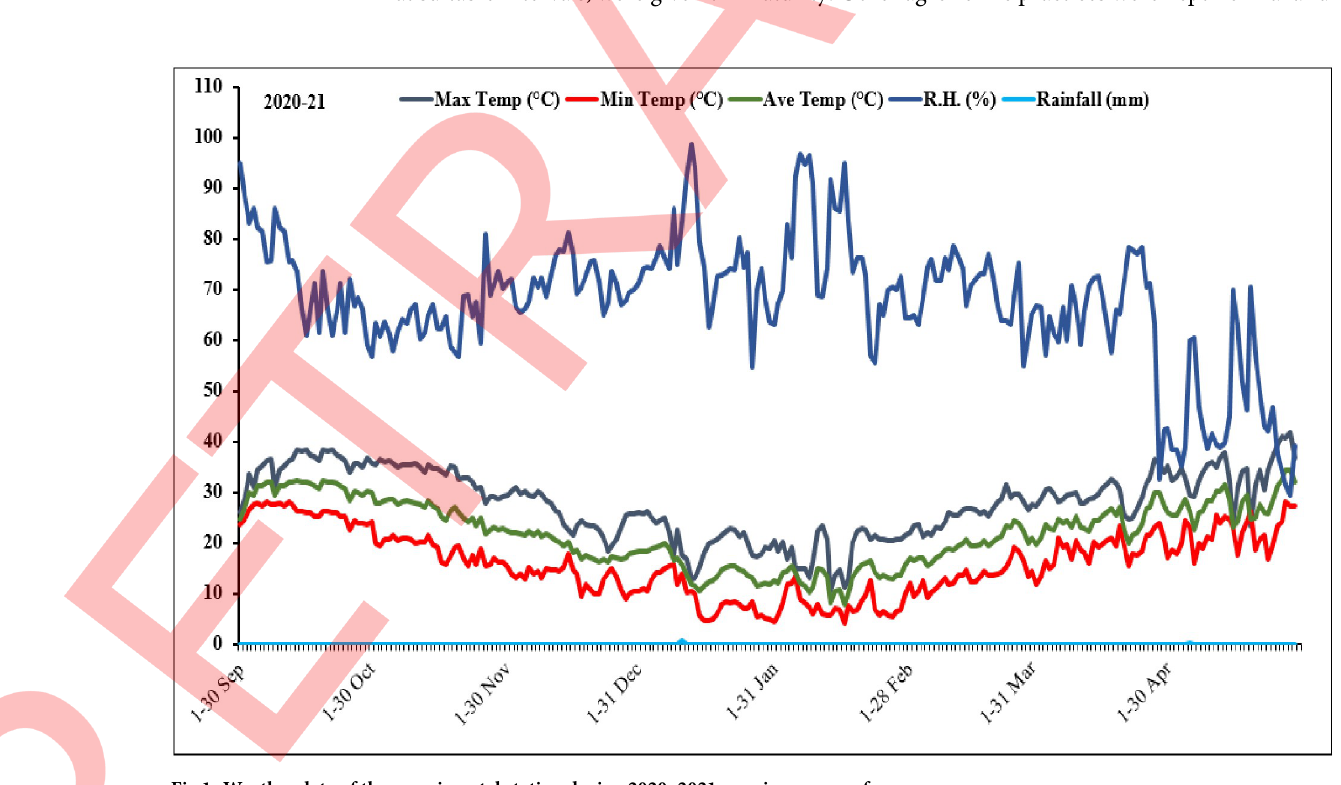
Fig 1. Weather data of the experimental station during 2020–2021 growing season of crop.